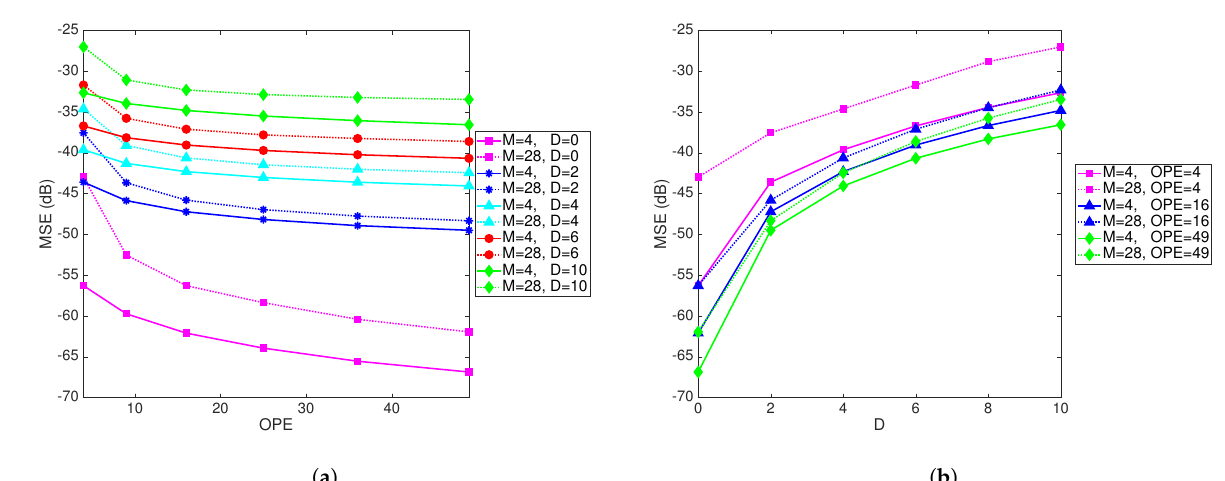
Figure 6. ( a ) MSE as a function of the number of observations per PE (OPE) for different M and different delays. Number of PEs is fixed at 9. ( b ) MSE as a function of delay for different M and the number of observations per PE. Number of PEs is fixed at 9.